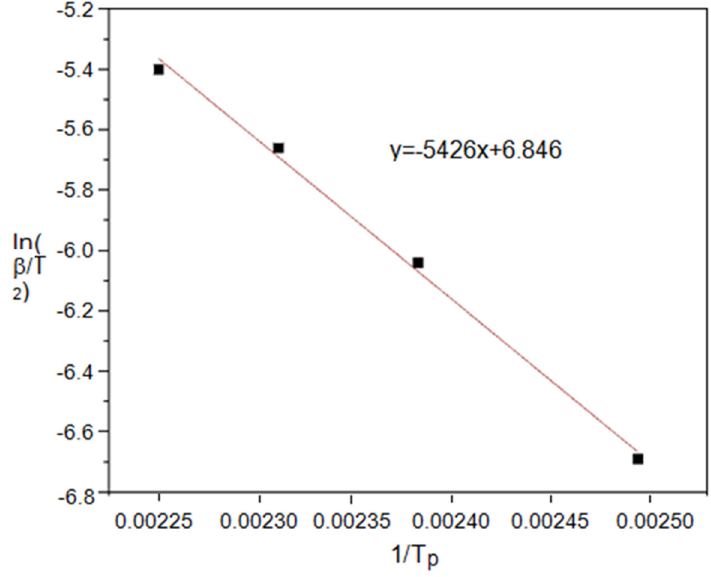
Figure 6. Linear regression equation between ln( β ⁄ T 2 ) and 1 ⁄ T p.